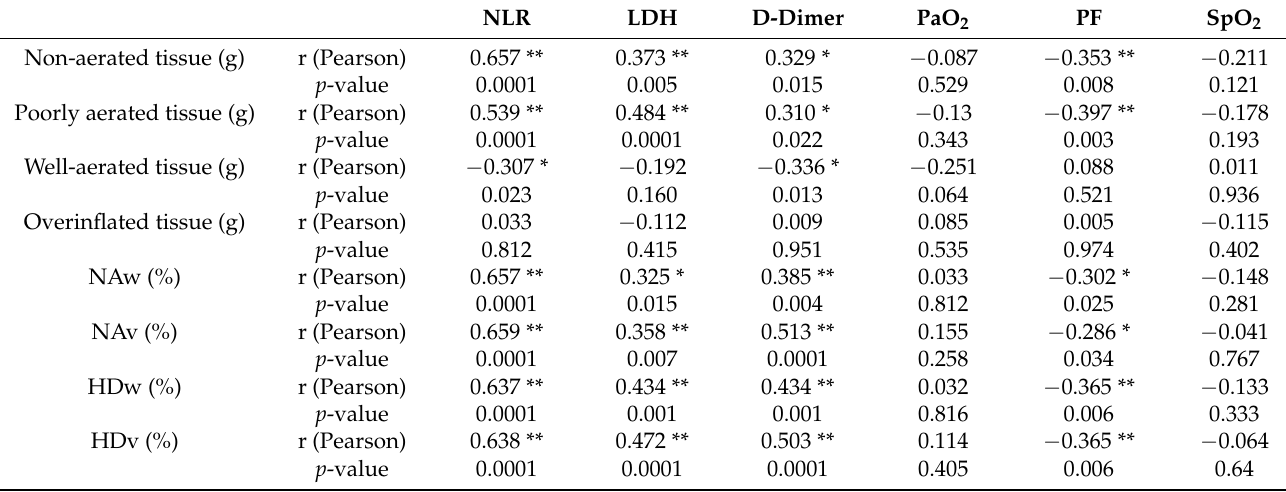
NLR: neutrophile-to-leucocyte ratio; LDH: lactate dehydrogenase; PaO 2 : oxygen partial pressure; SpO 2 : peripheral oxygen saturation; PF: PaO 2 /FiO 2 ; NAw (%): non-aerated weight percentage; NAv (%): non-aerated volume percentage; HDw (%): high-density weight percentage; HDv (%): high-density volume percentage; * significant difference: level of significance: p -value < 0.05; ** significant difference: level of significance: p -value <